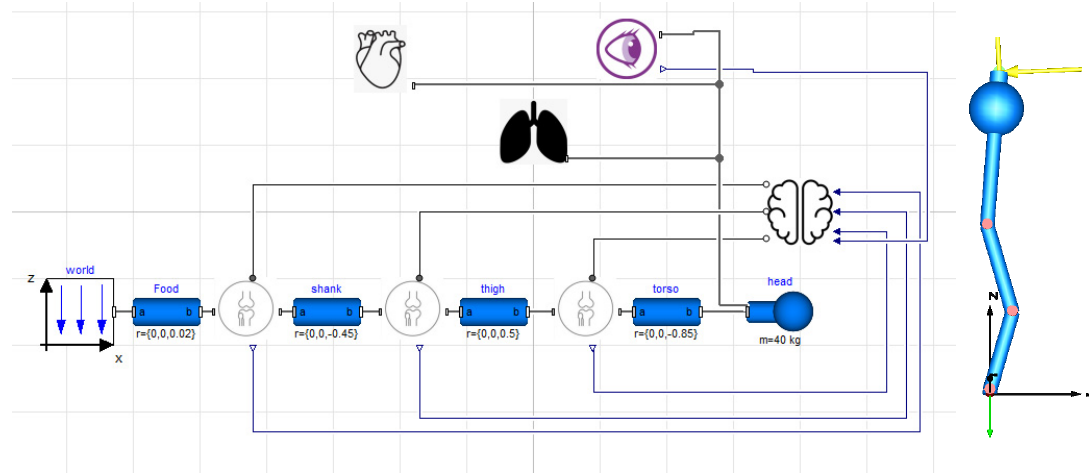
Figure 2. Left: Structure of the TIP model with Modelica; right: animation of the model (green: force vector gravitational acceleration 9.81 m/s; yellow: direction of action of the disturbances.